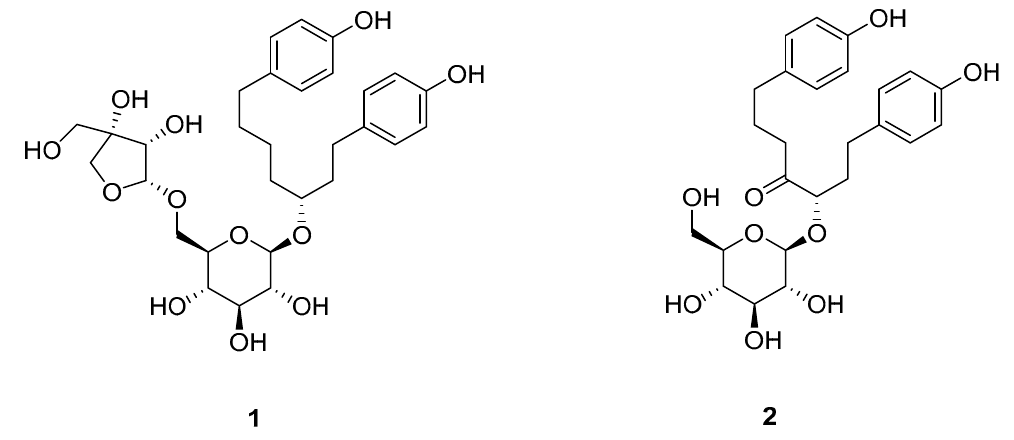
Figure 1. Chemical structure of two diarylheptanoids from B. platyphylla bark: aceroside VIII ( 1 ), and platyphylloside ( 2 ).